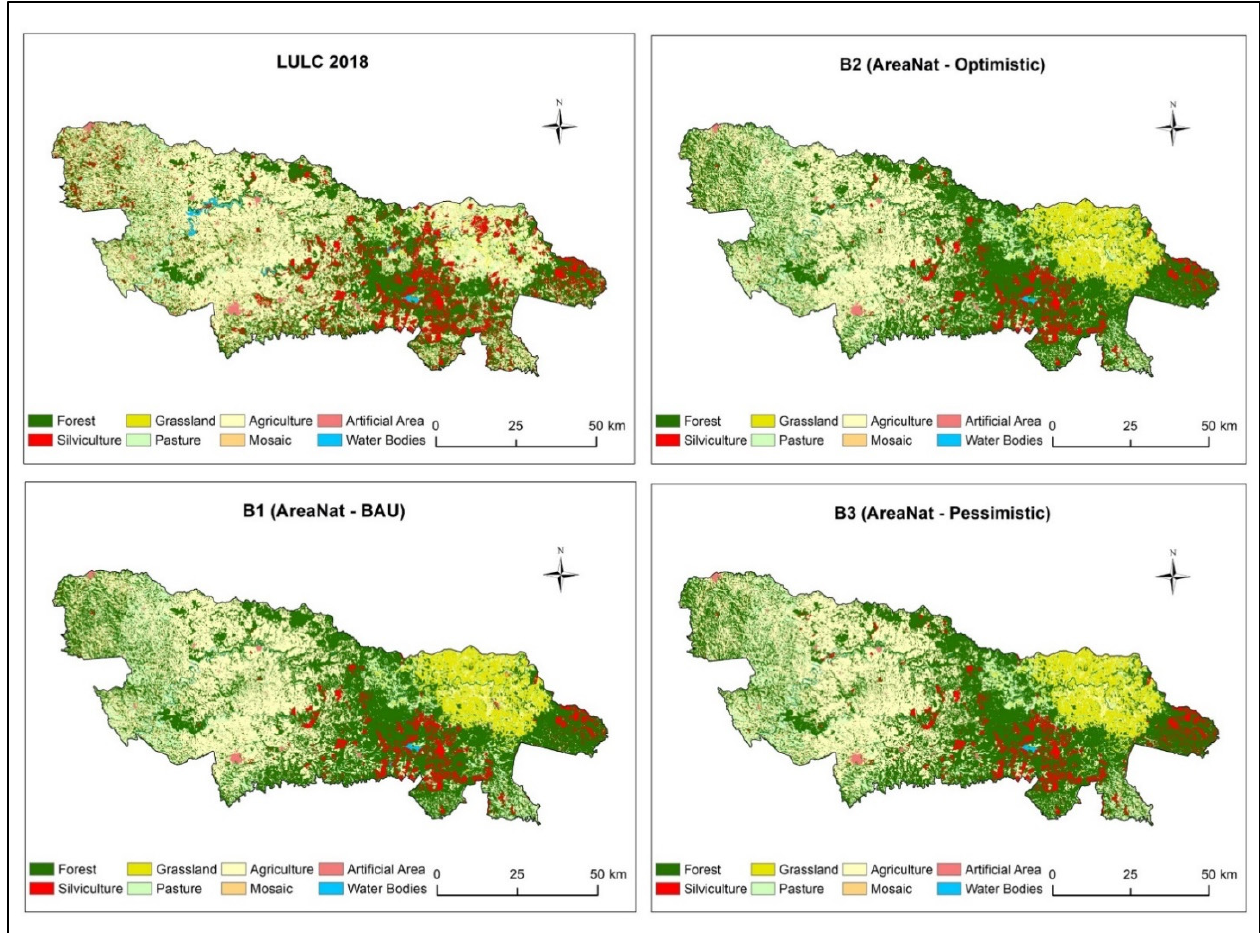
Figure 5. Scenario B—LULC evolution trends of the predictive scenarios for 2036—Chapecó River EC/SC, Brazil. Table 11. LULC evolution trends of the predictive scenarios B.